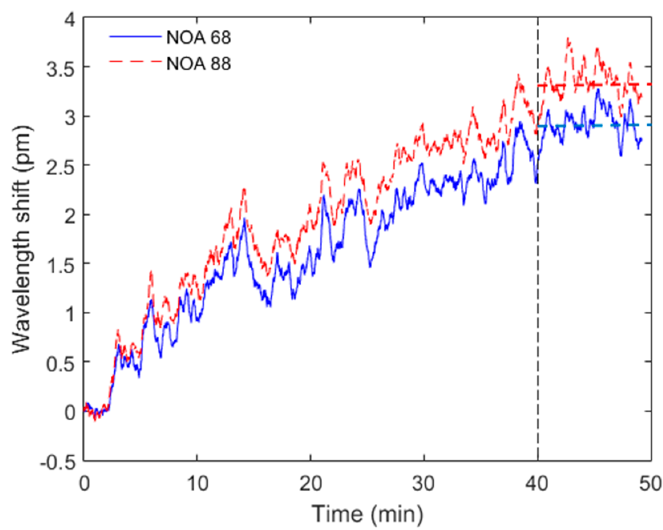
Figure 4. Moisture absorption tests for the NOA 68 and NOA 88 coated FBGs immersed in a fluid container for 50 min.